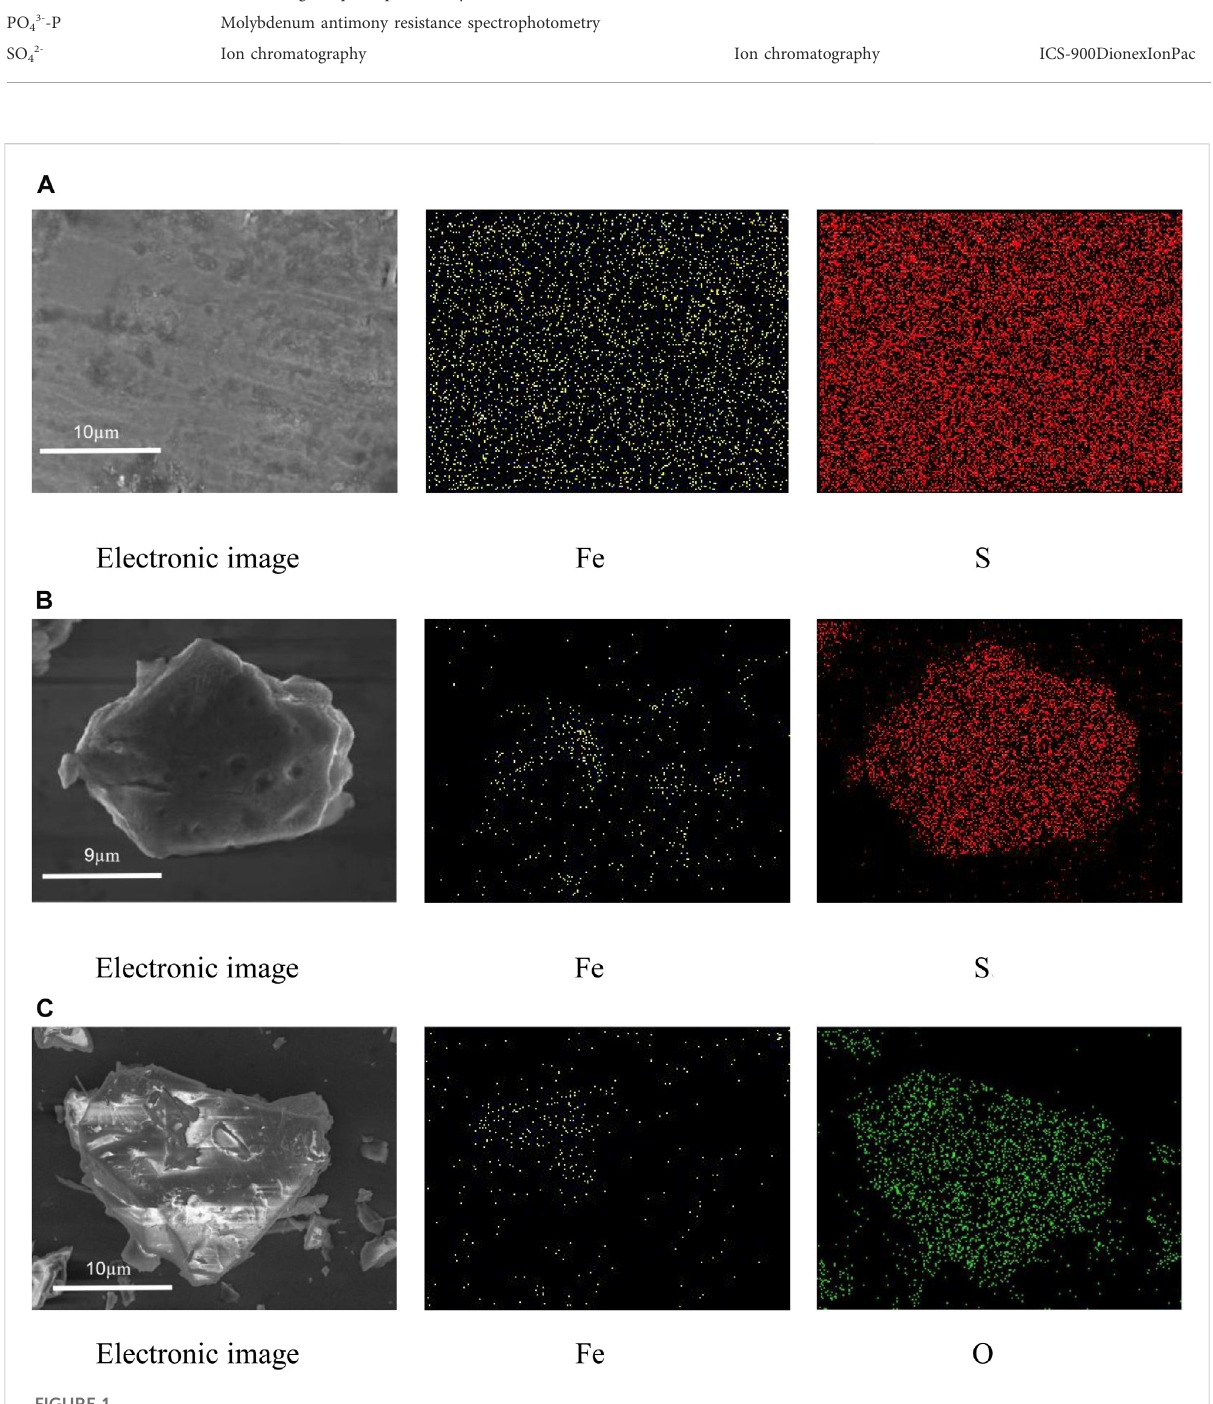
Frontiers in Environmental